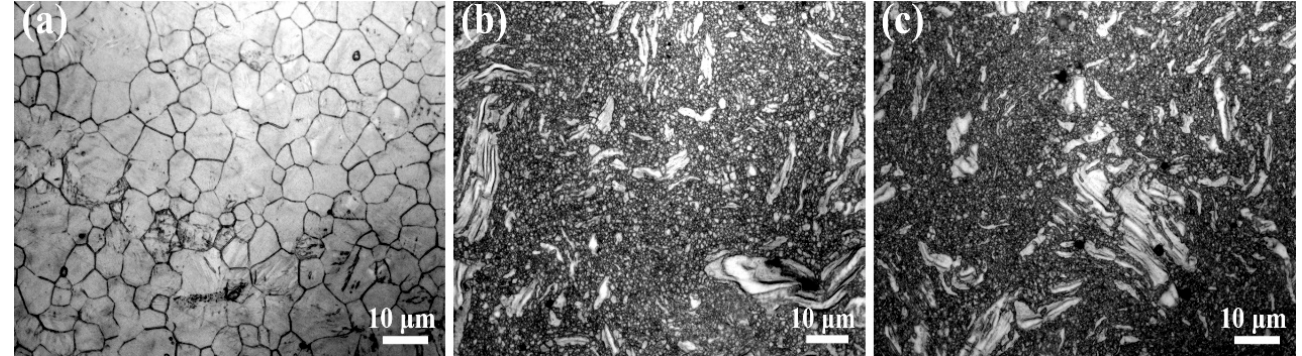
Figure 2. Metallographic images of ( a ) ZM20, ( b ) ZM21, and ( c ) ZM22 alloys.